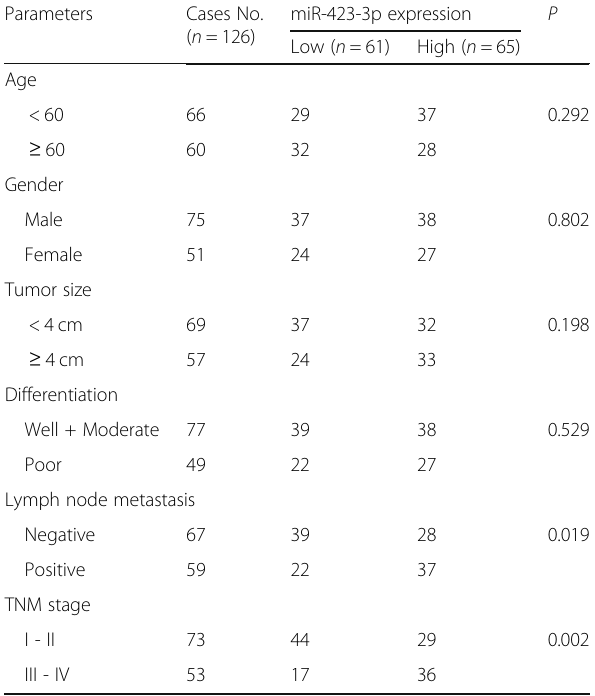
Table 1 Correlation between miR-423-3p expression levels and clinical features in lung cancer patients